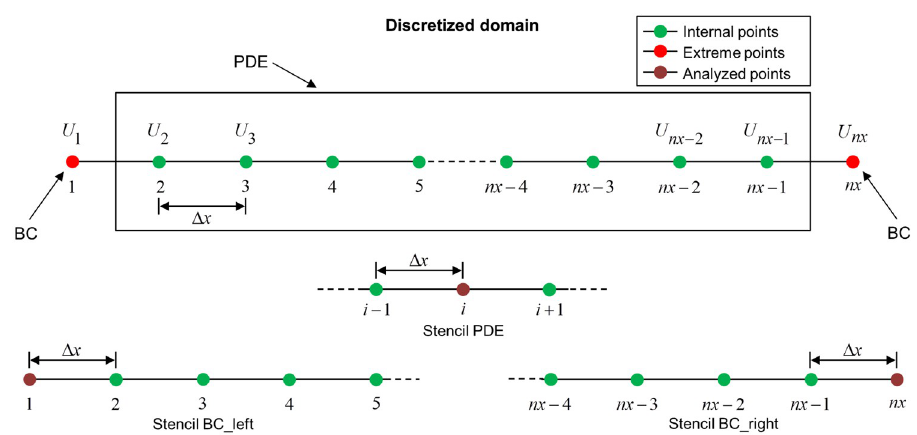
Fig 2. Uniform mesh of nx points in 1D for the FDM scheme. The image shows the stencil and points where the wave (PDE) and the boundary conditions (BC) equations are